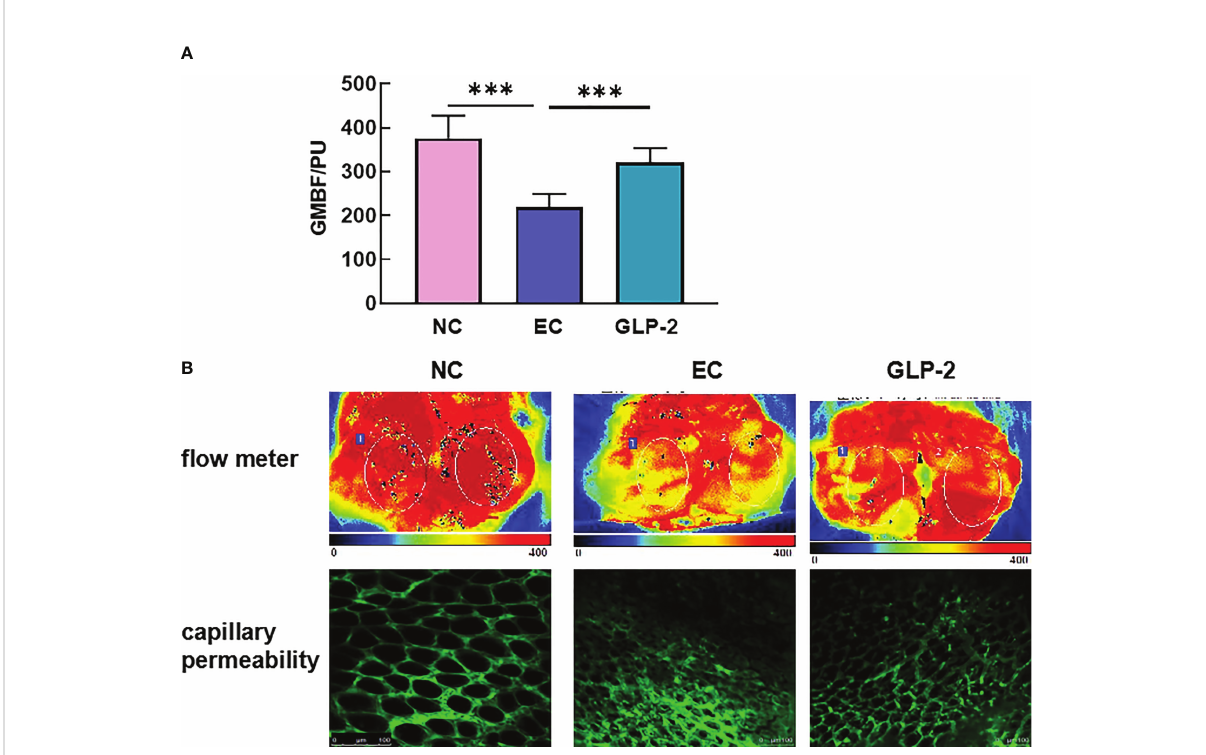
FIGURE 3 Effect of GLP-2 on the gastric mucosal blood fl ow in the ethanol-induced gastric mucosa among normal control (NC), ethanol model (EC) and glucagon-like peptide-2 (GLP-2) groups. (A) Changes in gastric mucosal blood fl ow measured using a laser Doppler fl ow meter. (B) gastric mucosal blood fl ow heat plot based on a laser Doppler fl ow meter (upper), vascular morphology, and capillary permeability using a 2-photon microscope (lower). ***P <